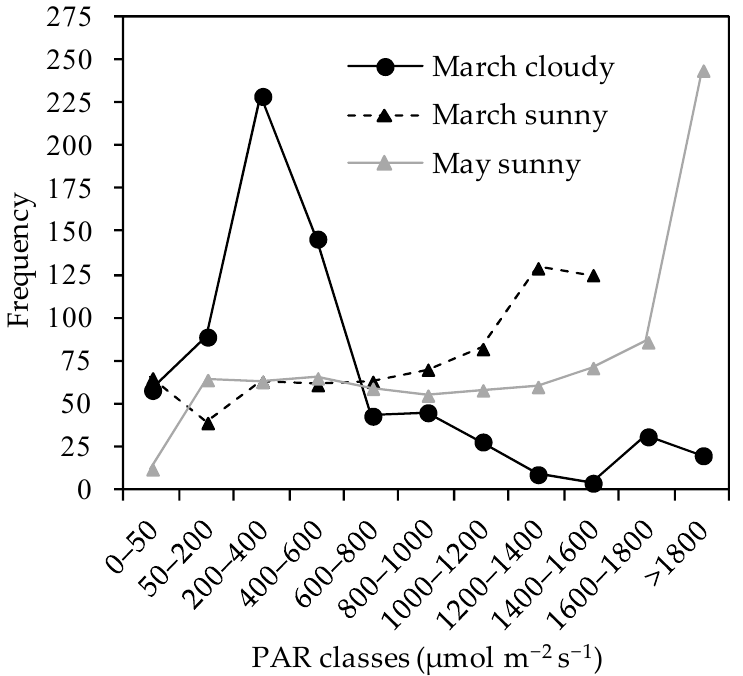
Figure 3. Class frequency distributions of incident PAR values measured above the canopy every minute from dawn to dusk, in three different days, two in March (one clear and one overcast) and one in May (clear). Each point is not an average, but is the frequency for the individual sample day, therefore standard error cannot be calculated. Reasons for showing these three individual sample days are explained in the text.